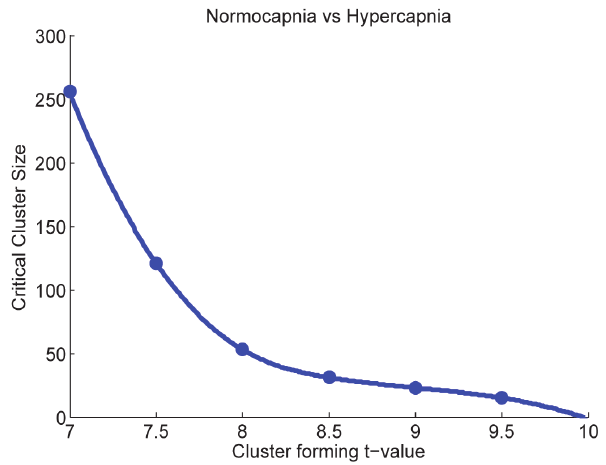
Figure 3. Plot of initial t-threshold against critical cluster extent. Plot of initial t-threshold (p , 0.05 FWE corrected) against critical cluster extent. A cubic spline curve was fitted to the calculated data